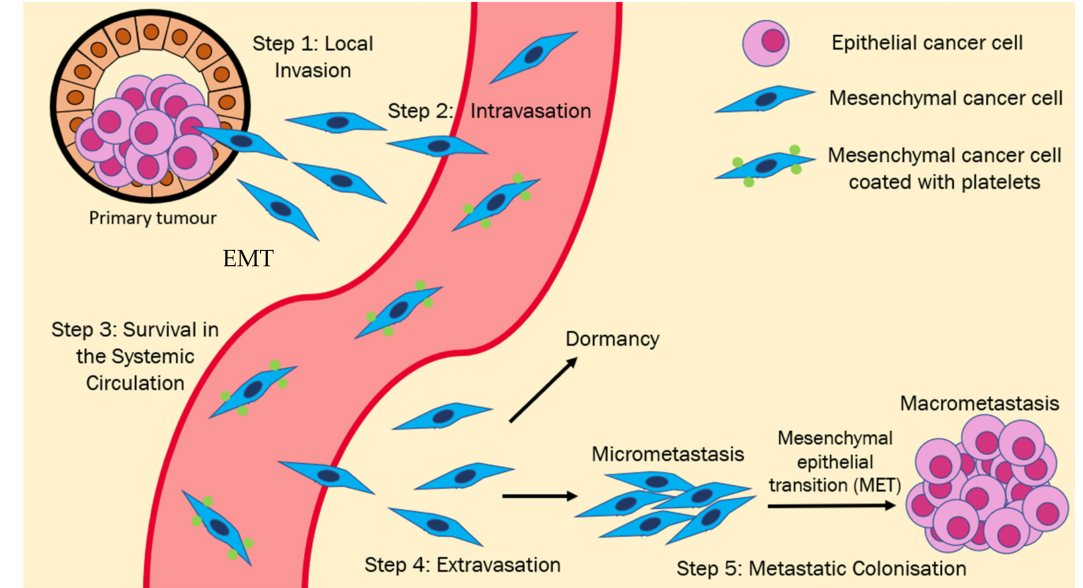
Figure 1. EMT-MET model for the metastatic cascade: Epithelial cancer cells undergo EMT, which causes them to lose their cell-cell junctions and gain the ability to invade the surrounding tissue parenchyma (Step 1). These EMT-induced cells may then intravasate into the systemic circulation (Step 2) and must survive in the circulation (Step 3) before reaching the target organ site. Upon reaching the target organ site, the cells must then extravasate into the tissue parenchyma (Step 4), following which they may either enter a state of dormancy or form micro metastases. Subsequent development into clinically detectable and potentially life-threatening macro metastases requires MET activation (Step